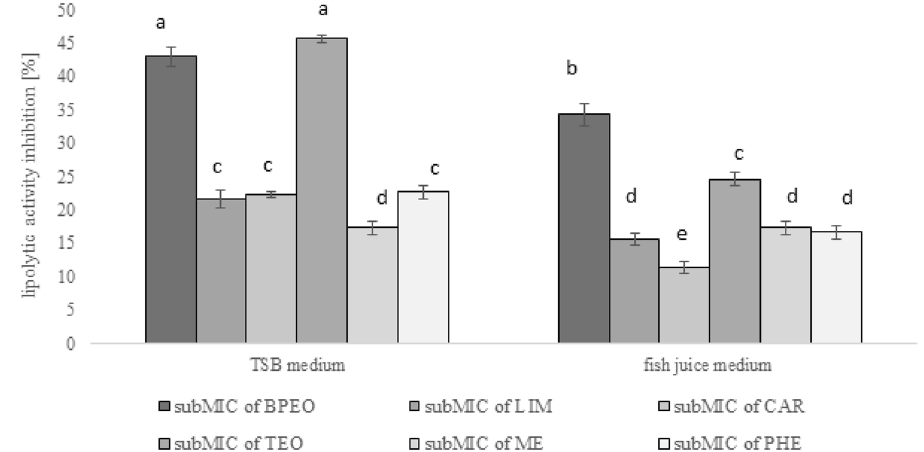
Figure 7. Inhibition of lipolytic activity of P. psychrophila KM02 grown on modified TSB and fish juice medium supplemented with subMICs of black pepper (BPEO) and tarragon essential oils (TEO), limonene (LIM), β-caryophyllene (CAR), methyl eugenol (ME), and β-phellandrene (PHE). Values are calculated from three independent replicates. Error bars represents standard deviation values. The same letter indicates not statistically differences in expression as provided by Tukey’s test after ANOVA analysis (F = 308.6, p <